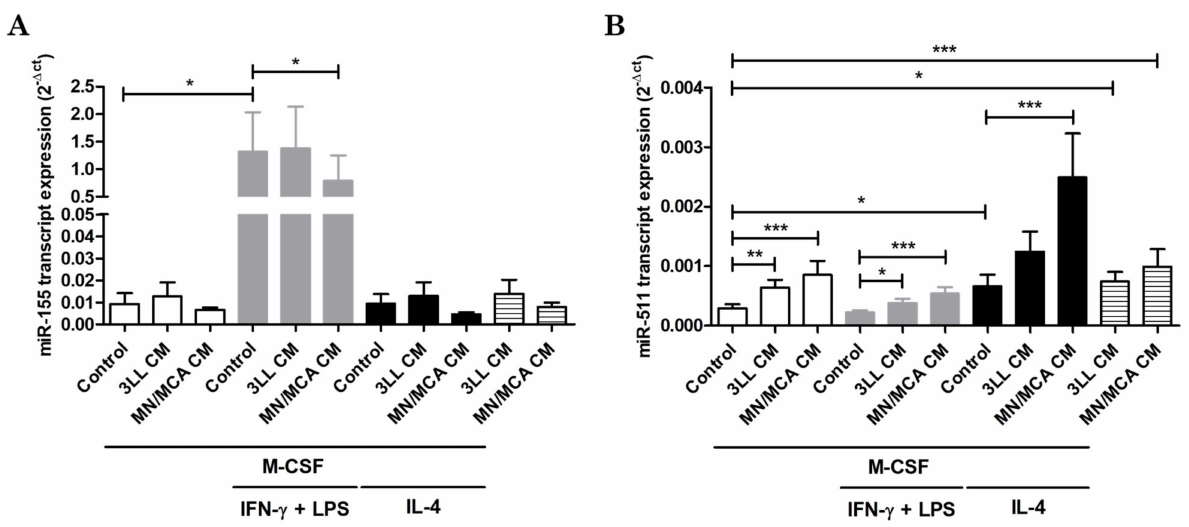
Figure 2. miR-155 and miR-511 expression is modulated by tumor-conditioned media. Bone marrow hematopoietic progenitor cells were collected and stimulated with M-CSF for 5 days in the presence of 3LL or MN/MCA-conditioned media (CM). After this period, IFN- γ and LPS or IL-4 were added to cultures for a further 24 h to induce polarization. Graphs show the abundance of transcripts encoding miR-155 ( A ) and miR-511 ( B ) by M0 (white bars), M1 (grey bars), M2 (black bars), and CM alone (striped bars)-stimulated cells. Results are shown as 2 − ∆ ct . n ≥ 3 independent experiments. *: p ≤ 0.05; **: p ≤ 0.01; ***: p ≤